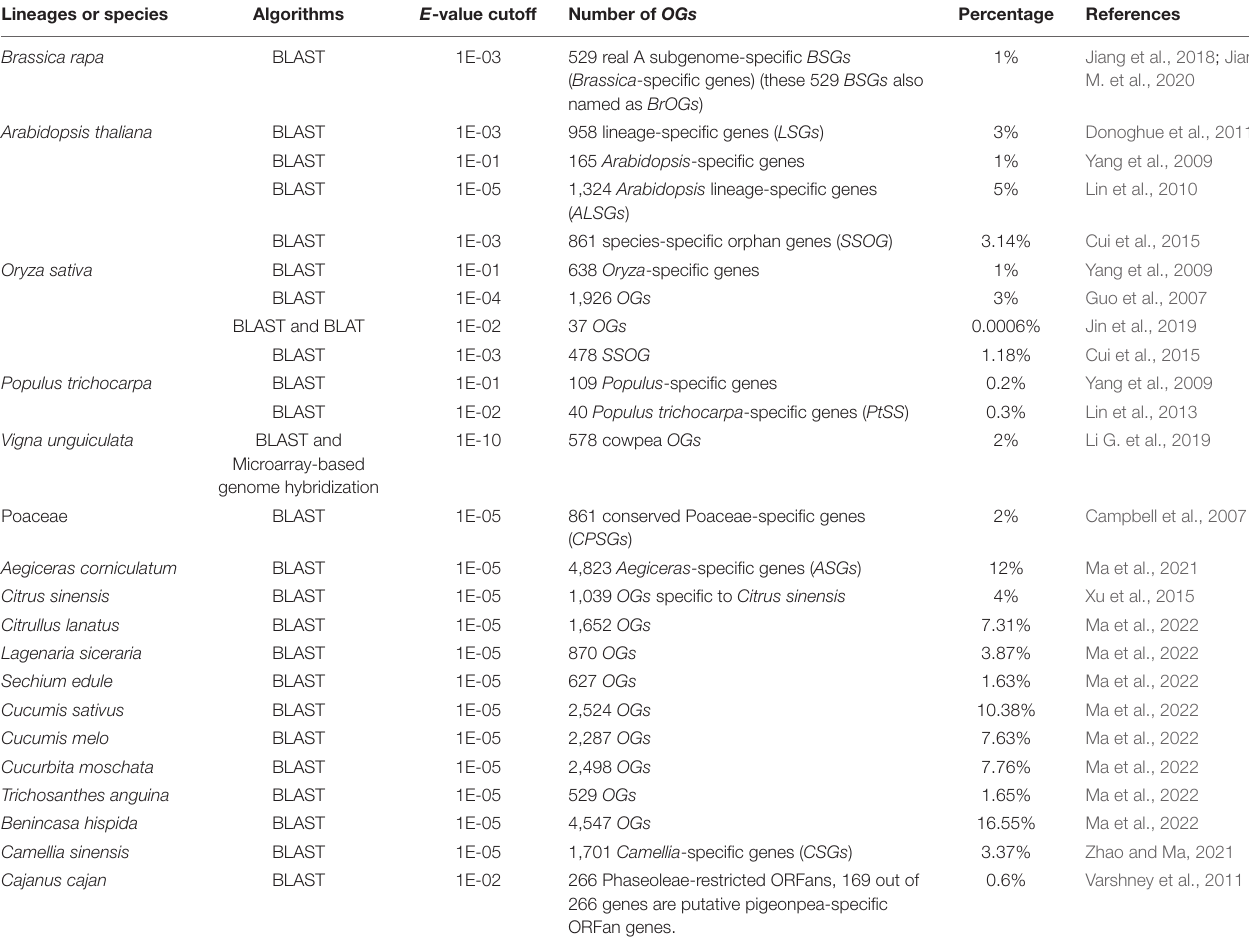
TABLE 1 | Identification of orphan genes ( OGs ) in